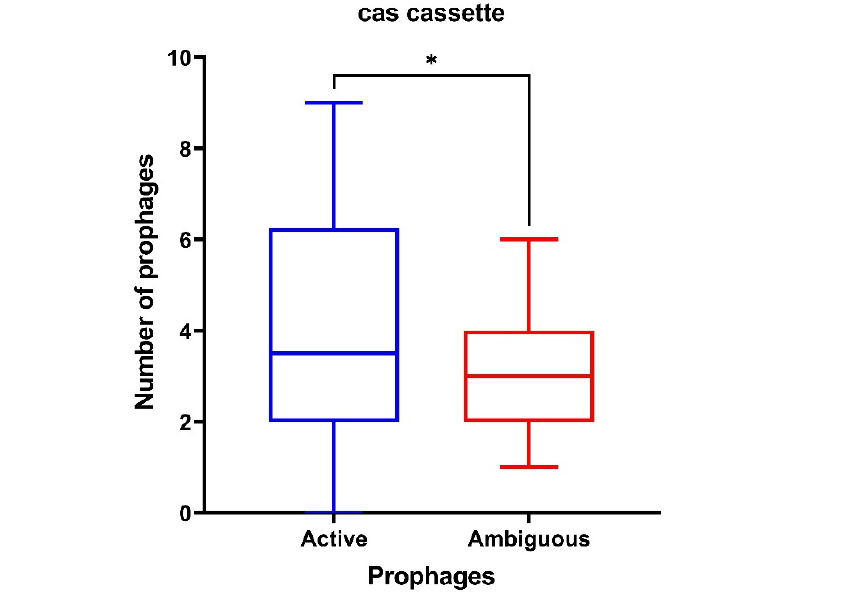
Figure 7. The number of active and ambiguous prophages among CriePir P. aeruginosa isolates having no cas cassettes. * indicates the level of significance p < 0.05.